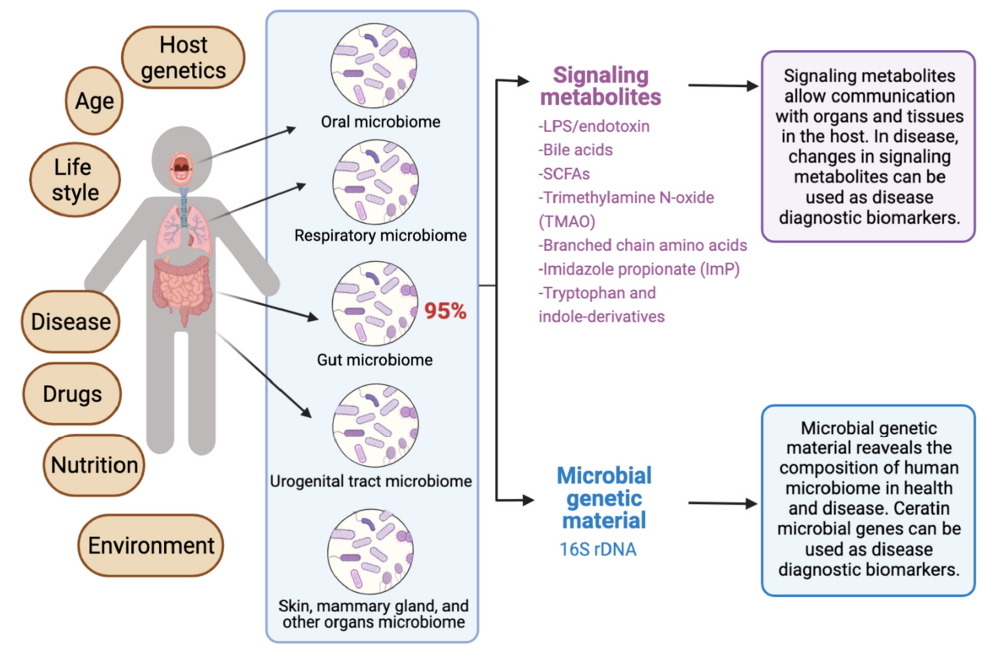
Figure 1. Exploiting the human microbiome for diagnostic disease biomarkers.